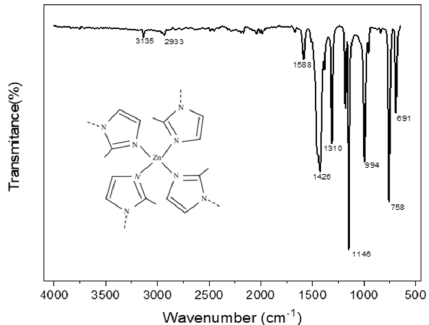
Figure 1. Fourier transform infrared (FTIR) spectra of ZIF-8